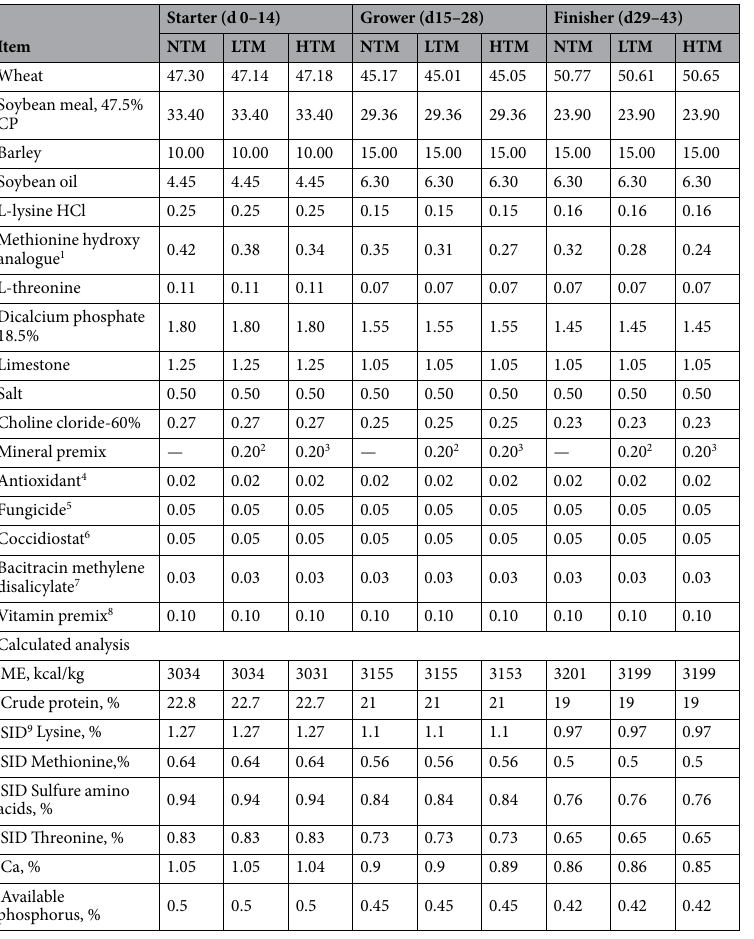
Table 1. Ingredient composition and nutrient content of the experimental diets. 1 Methionine hydroxy analogue (MHA ® ) (Novus International, Inc., St. Charles, MO). 2 Mineral premix for LTM treatment supplied per kilogram of diet: FeSO 4 ·H 2 O, 40 mg; Calcium Iodate, 1.25 mg; Sodium Selenite, 0.3 mg; Mintrex ® Zn, 32 mg; Mintrex ® Cu, 8 mg; Mintrex ® Mn, 32 mg. 3 Mineral premix for HTM treatment supplied per kilogram of diet: FeSO 4 ·H 2 O, 40 mg; Calcium iodate, 1.25 mg; Sodium selenite, 0.3 mg; Mintrex ® Zn, 64 mg; Mintrex ® Cu, 16 mg; Mintrex ® Mn, 64 mg. 4 Santoquin ® (Novus International, Inc., St. Charles, MO). 5 Mold guard ® (Kemin, Des Moines, Iowa). 6 Coban ® 90 (Elanco Animal Health, Greenfield, IN). 7 BMD ® (Zoetis, Inc., Florham Park, NJ). 8 Vitamin premix supplied per kilogram of diet: retinol, 9.2 mg; cholecalciferol, 100 µ g; dl- α -tocopherol, 90